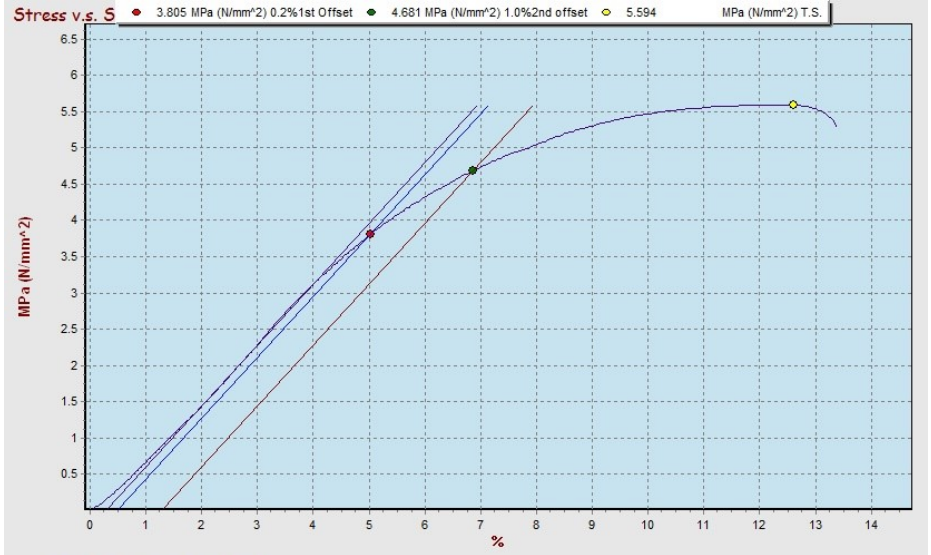
Figure 7. Stress-strain relationship on bending test of polypropylene–SBT composite with 30 vf% and 250 mesh particle size.